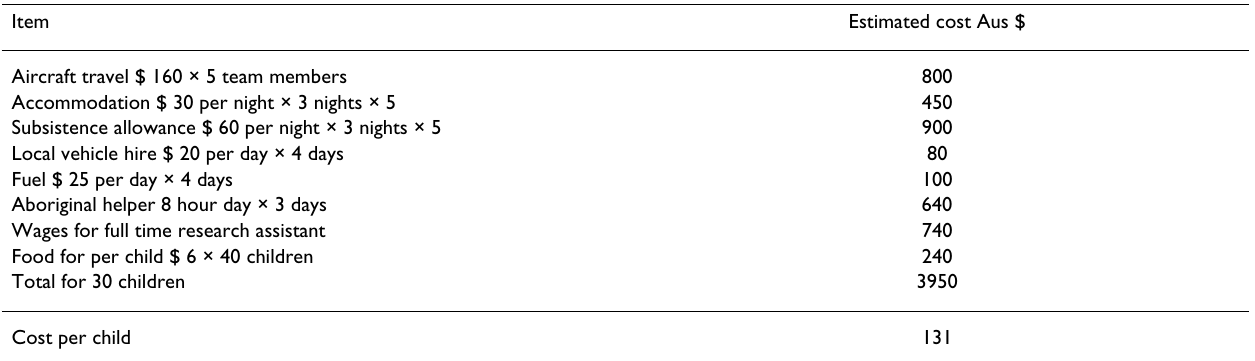
Table 6: Estimated minimal costs per child for 5 team members visiting a remote community for 4 days to see a potential 40 subjects and seeing 30